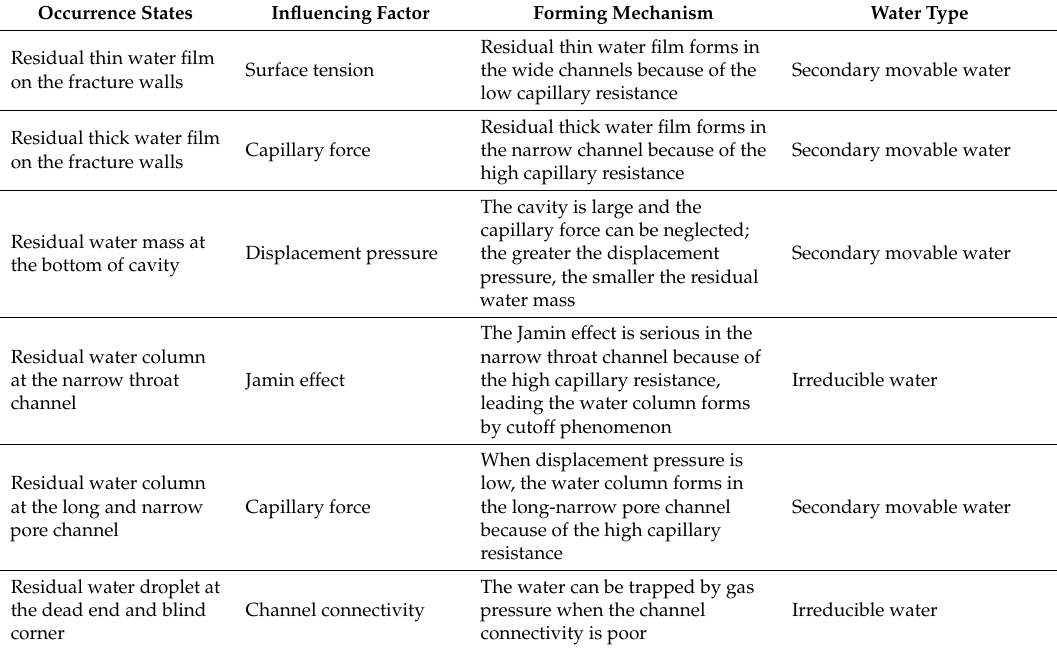
Table 3. Main types, influencing factor and forming mechanism of different type occurrence